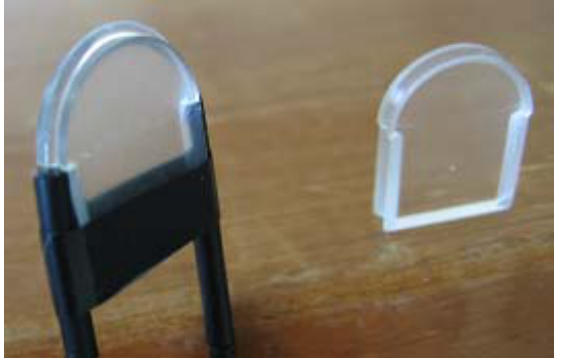
Figure 5. Optical fiber placed on a 6-milimeter-radius